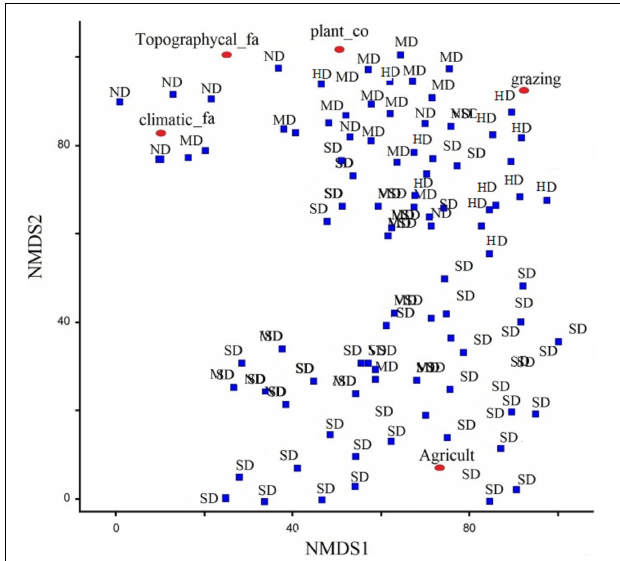
FIGURE 7 | Non-metric multi-dimensional scaling (NMDS) ordination for relating degradation classes [negligible (ND), medium (MD), high (SD), and severe (SD)] with plant composition, grazing, agriculture, topographical and climatic factors.